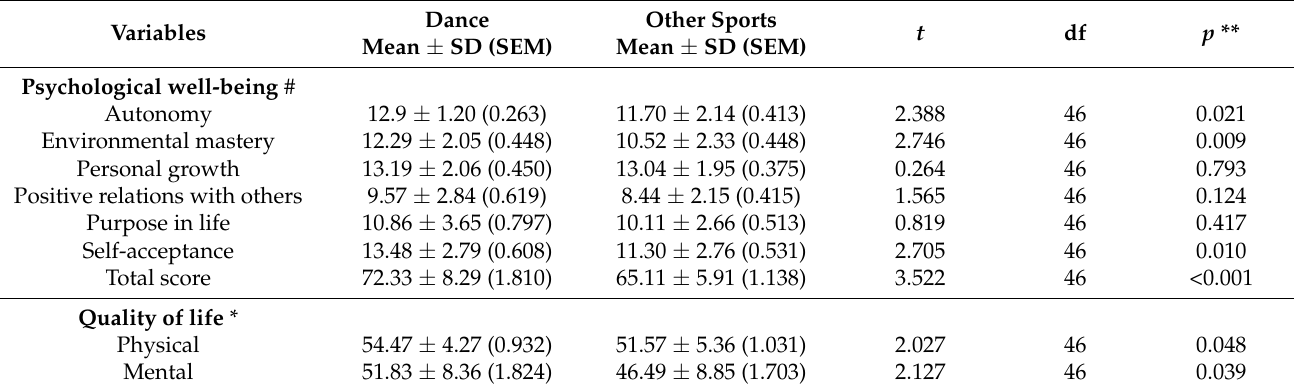
Table 2. Mean scores of psychological well-being scale and quality of life questionnaire in visually impaired dancers compared with visually impaired athletes practicing different